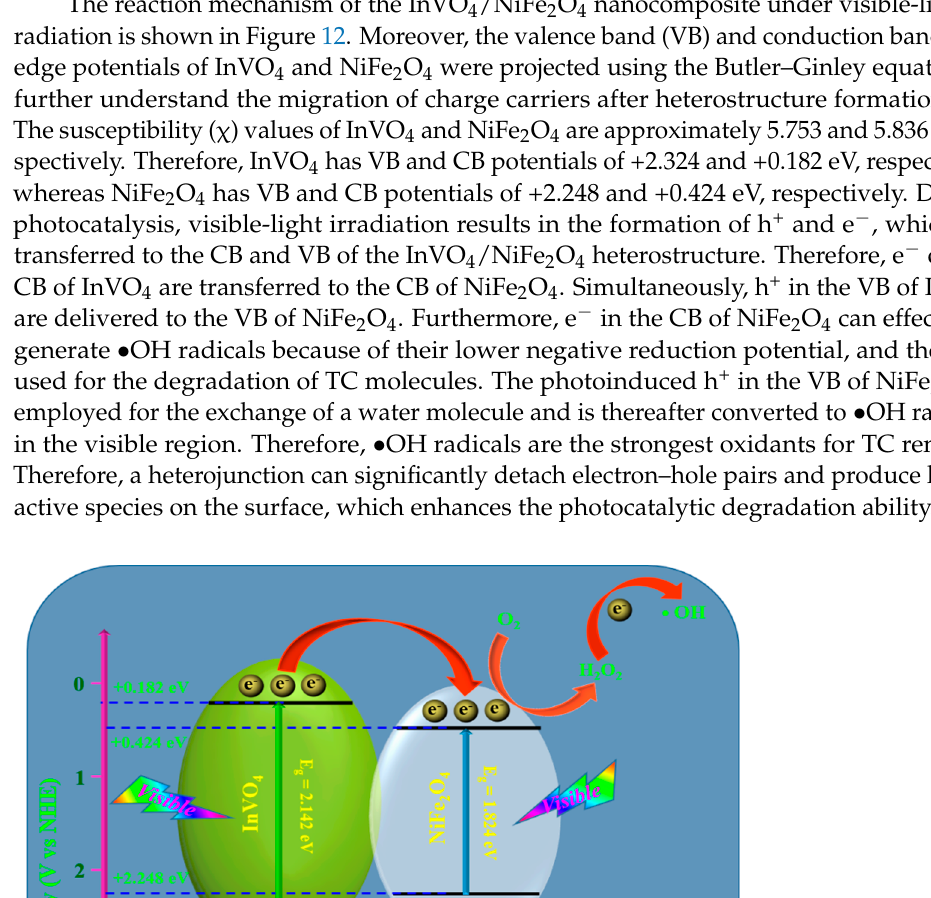
Figure 11. ( a ) Radical quenching experiment for the degradation of TC over IVNF-5.0 nanocompo- site, and ( b ) I–t curves of the samples under the ON–OFF states.